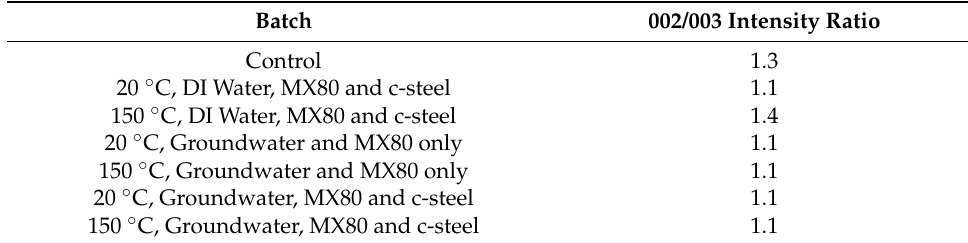
Table 7. Compiled 002/003 peak intensity ratios for each batch consignment.